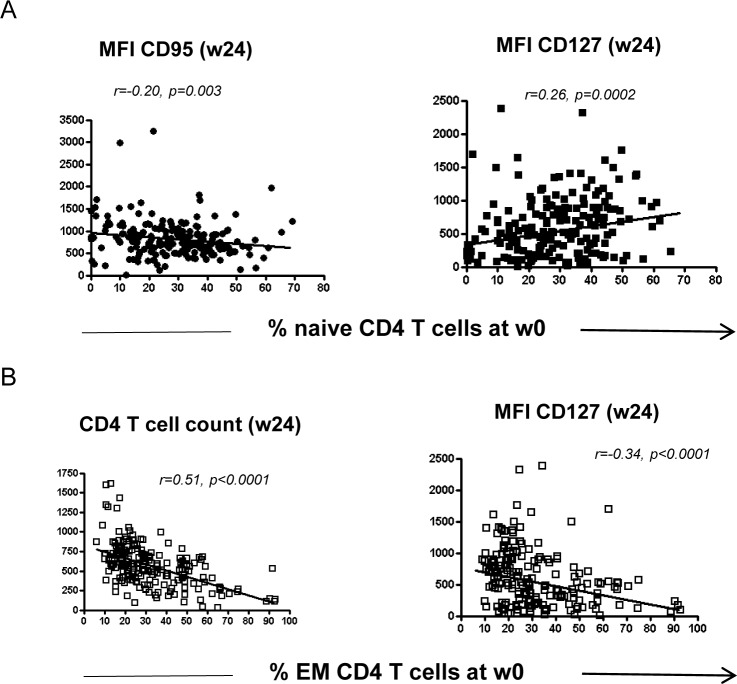
Baseline frequency (w0) of naive CD4 T cells (A) and EM CD4 T cells (B) correlate with several immune parameters after treatment (w24). The correlation analysis was performed by Spearman test and a p<0.05 was considered significant.